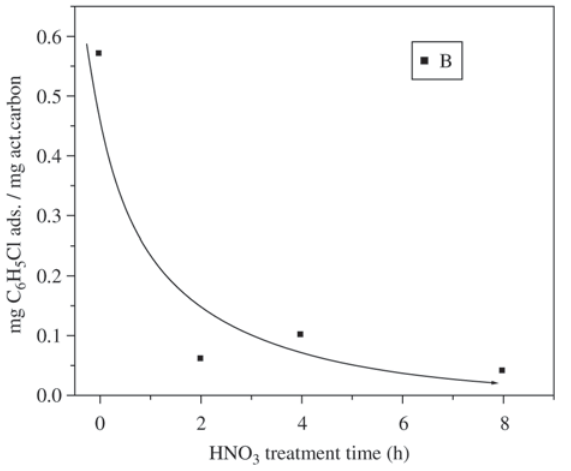
Figure 6. Chlorobenzene adsorption capacity on carbon treated with HNO for different reflux time. 3